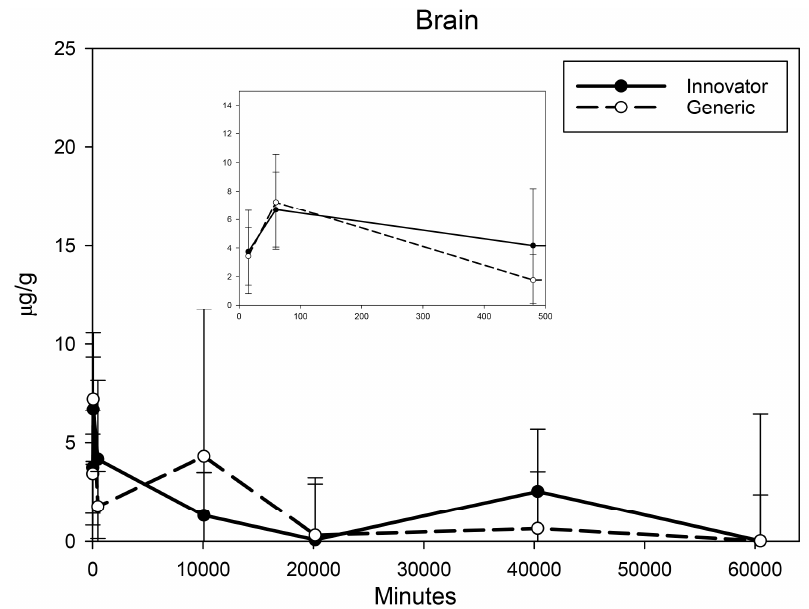
Figure 3. Brain mean iron concentrations over time. Endogenous (control) iron concentration was subtracted from both the innovator (solid) and the generic (dashed). Negative results are not graphed. Time points = 15 min, 60 min (1 h), 480 min (8 h), 10,080 min (1 week), 20,160 min (2 weeks), 40,320 min (4 weeks), 60,480 min (6 weeks). Inset shows the first three time points (15 min, 1 h, 8 h). Values are shown as mean + SD; n = 6 per group per time point.